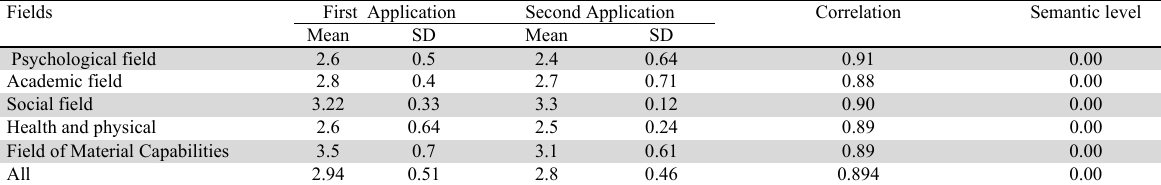
Correlation between the first and second